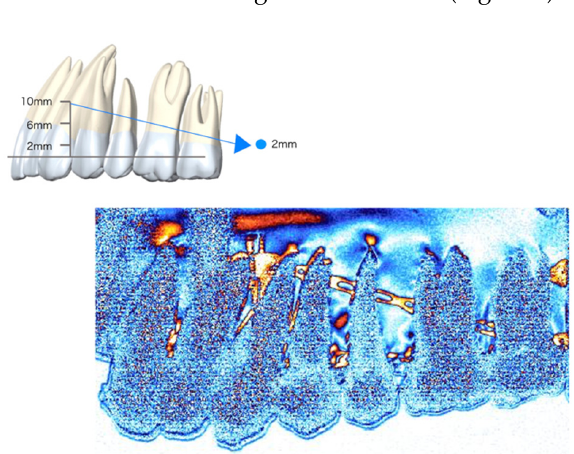
Figure 7. Ten-millimeter retraction hook and 2 mm positioned posterior anchor model.